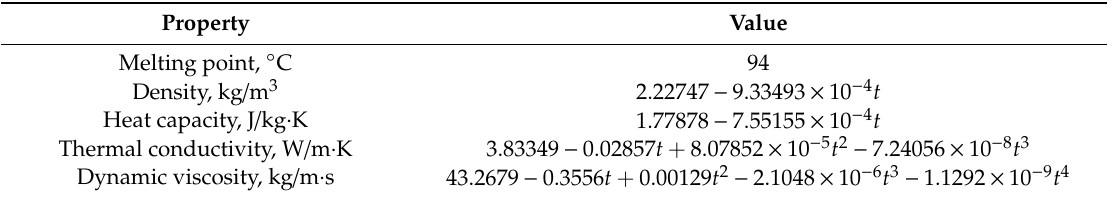
Table 3. Properties of the new type of molten salt